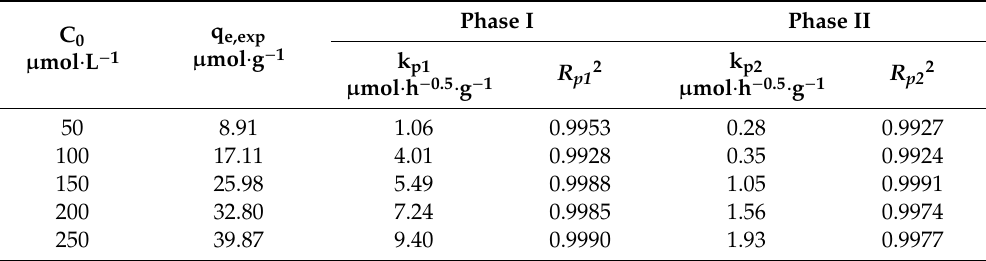
Fitting parameters of intraparticle di ff usion model under di ff erent mixed solution